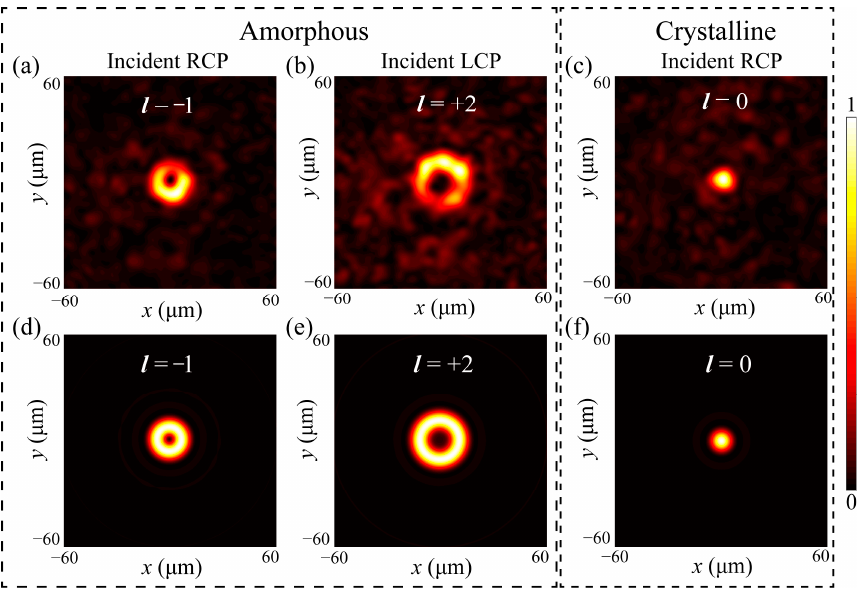
Figure 4. Simulated and theoretical performance of the designed multistate vortex beam generator. ( a , b ) The simulated electric field distributions when GSST is in A-state under RCP ( a ) and LCP ( b ) incidences. ( c ) The simulated electric field distributions when GSST is in C-state under RCP incidence. ( d – f ) The calculated results correspond to those in ( a – c ).